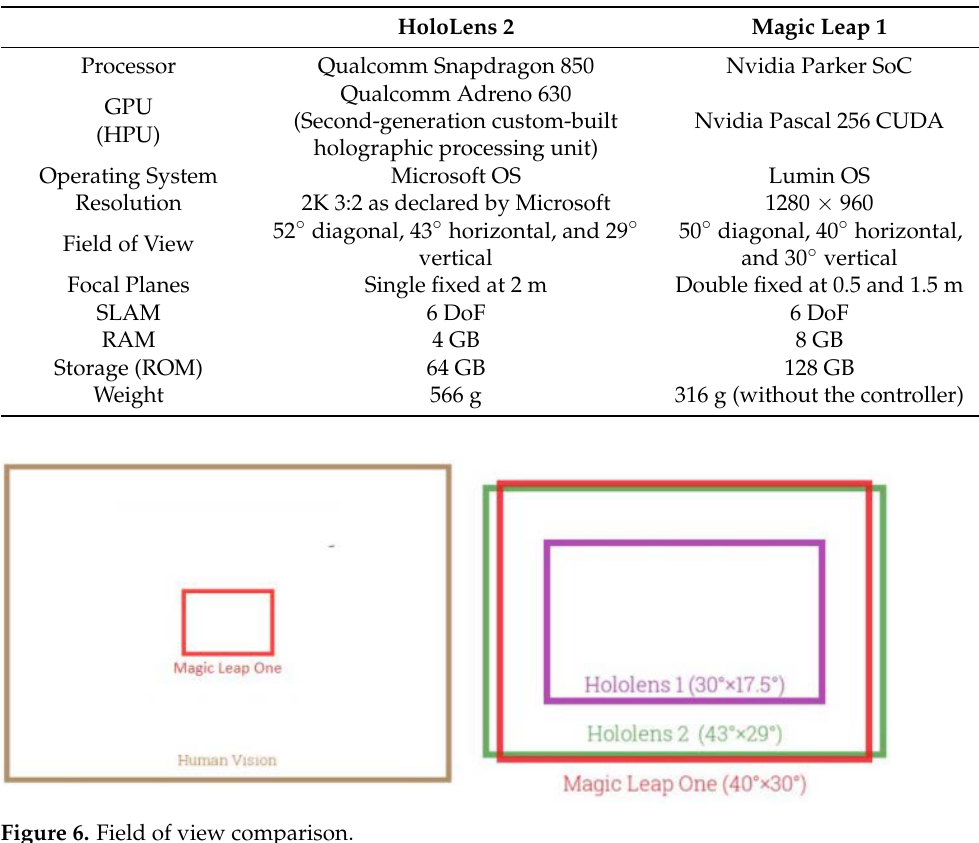
Table 1. Overview of major specifications that may influence device performance for the chosen medical application.